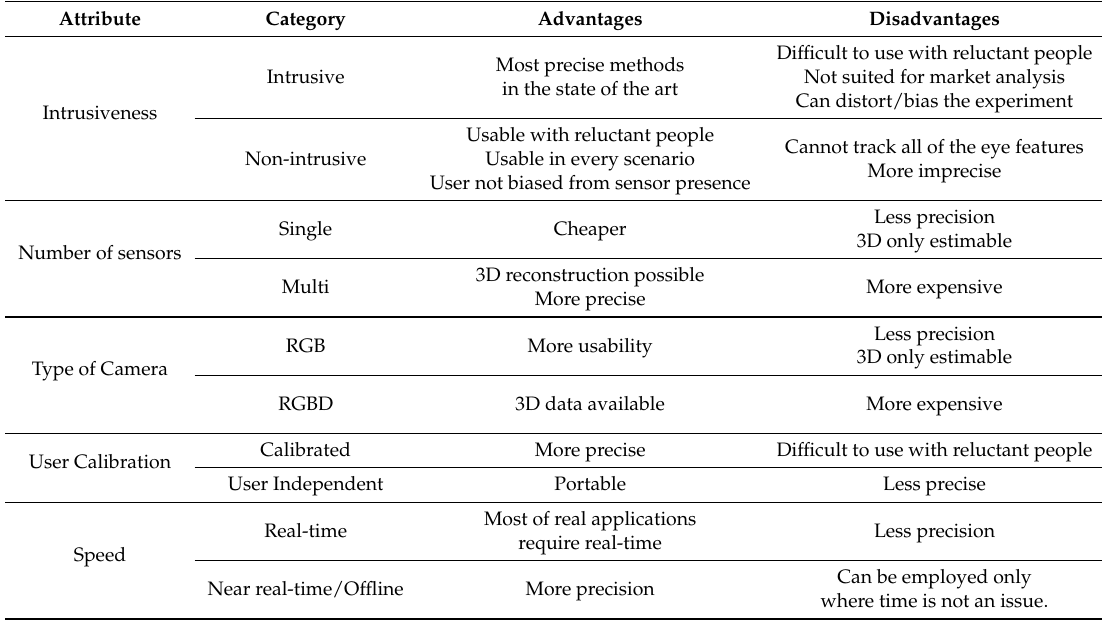
Table 3. A summary of the main attributes of a gaze estimation system, putting in evidence advantages and disadvantages of each